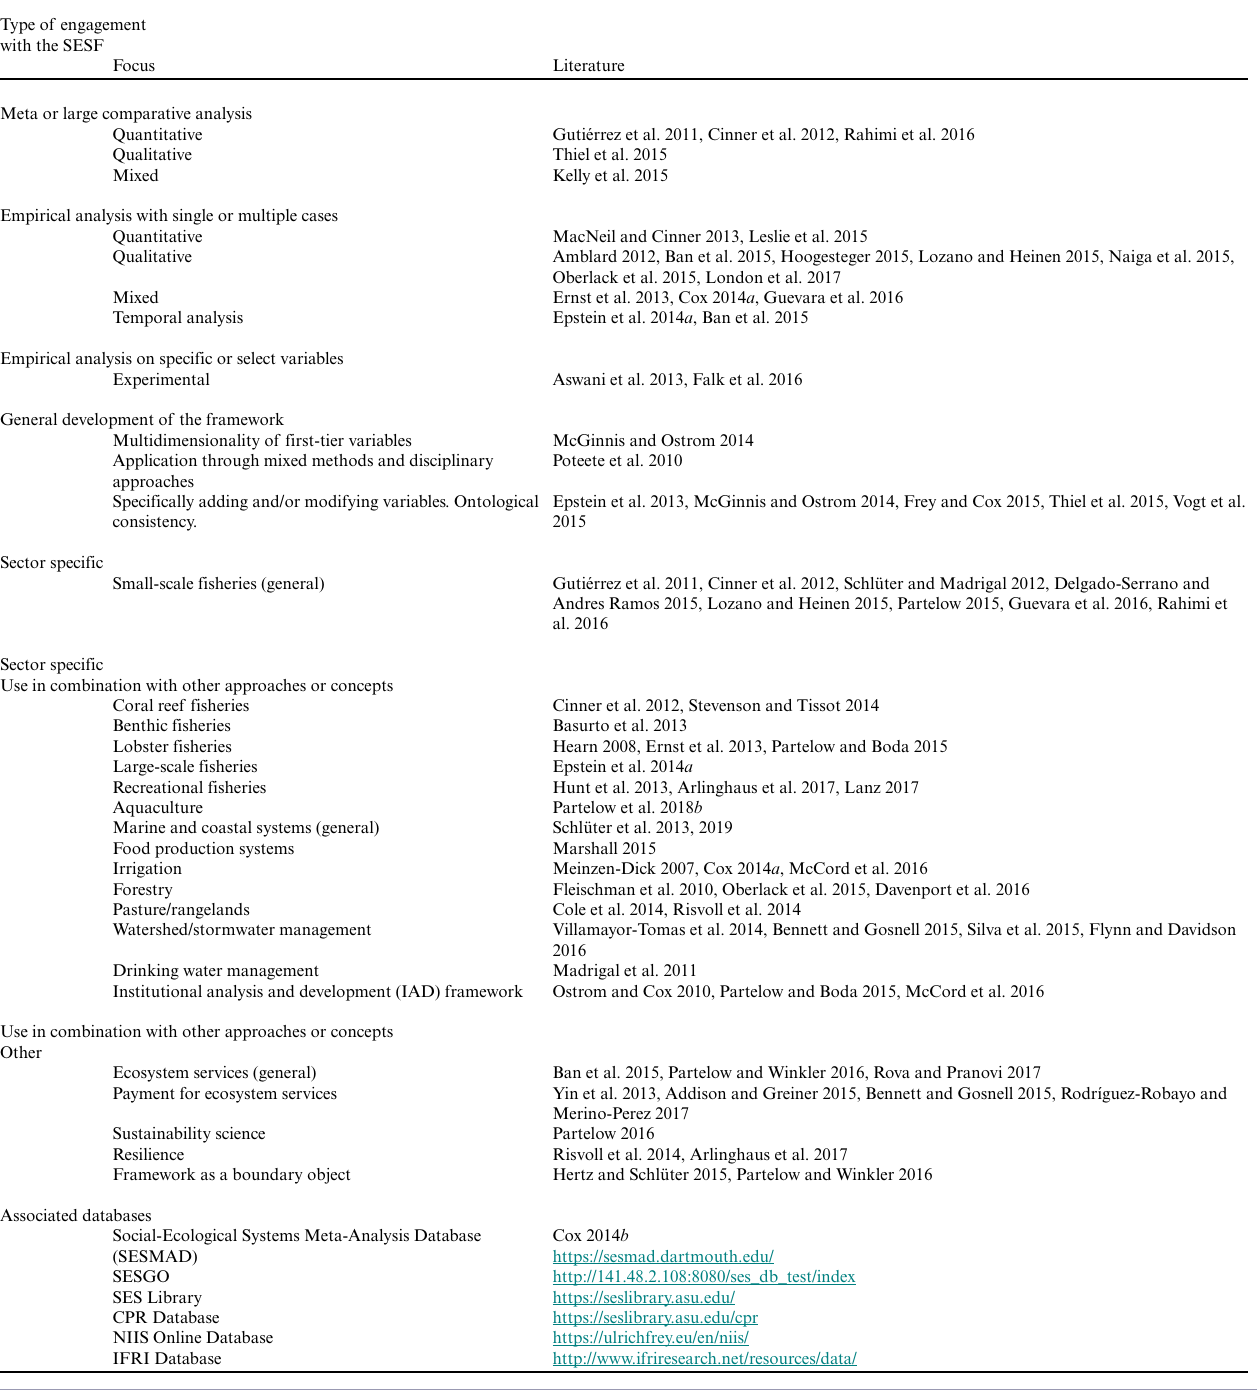
Table 2. The diversity of methods, contexts, and thematic areas under which the social-ecological systems framework is applied are shown with the relevant literature. The specific sectors in which the framework has been applied are shown. Associated concepts and databases related to the framework are